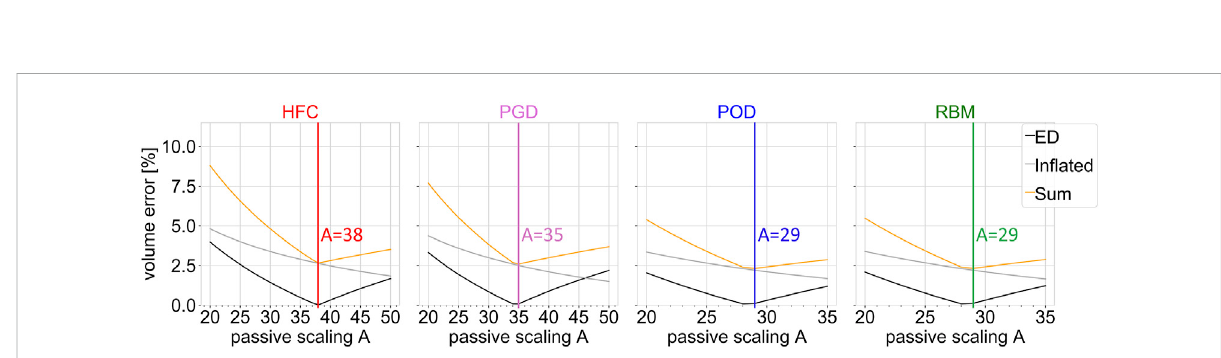
FIGURE 3 Objective function (sum; yellow) of the joint estimation of the passive material parameter and unloaded con fi guration, together with the single volume error contributions as function of the passive scaling parameter A. The ventricular volume of the simulation results is compared to the volume obtained from cine MRI data at the con fi guration in fl ated to the initial pressure (in fl ated; gray) and at the end-diastolic con fi guration (ED; black). Each subplot shows the result of the parameter sweep for one interpolated fi ber fi eld obtained by the four compared methods: HFC, PGD, POD, and RBM. The vertical lines indicate the optimum.